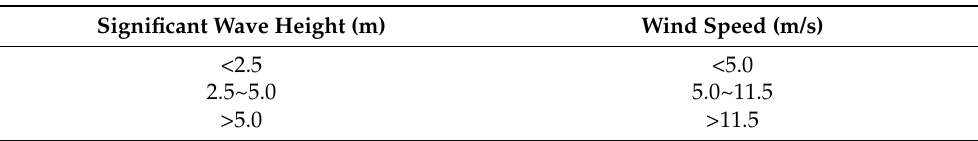
Table 2. The simulation frequency bands and frequency increments under different sea states. Reprinted with permission from ref. [22].